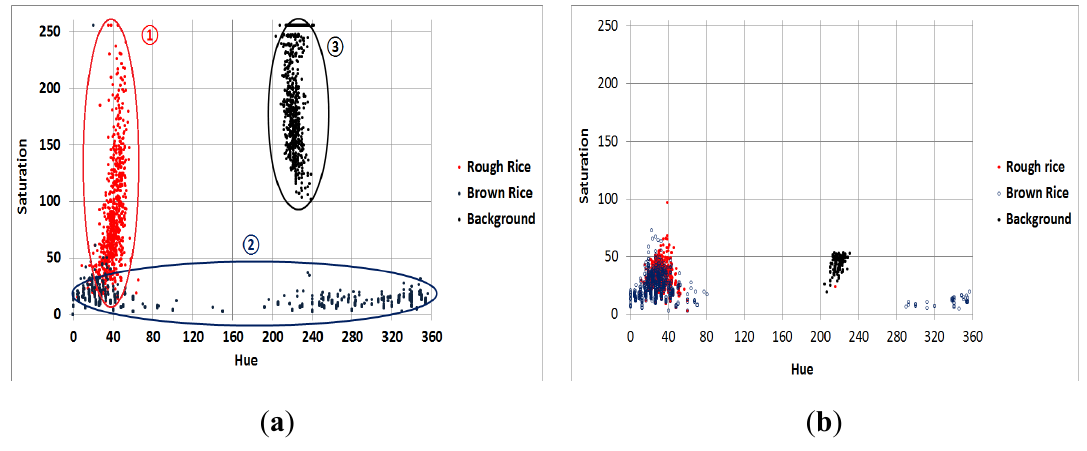
Figure 8. Saturation and hue distribution from frontlight images captured with the ( a ) double lighting system and ( b ) conventional